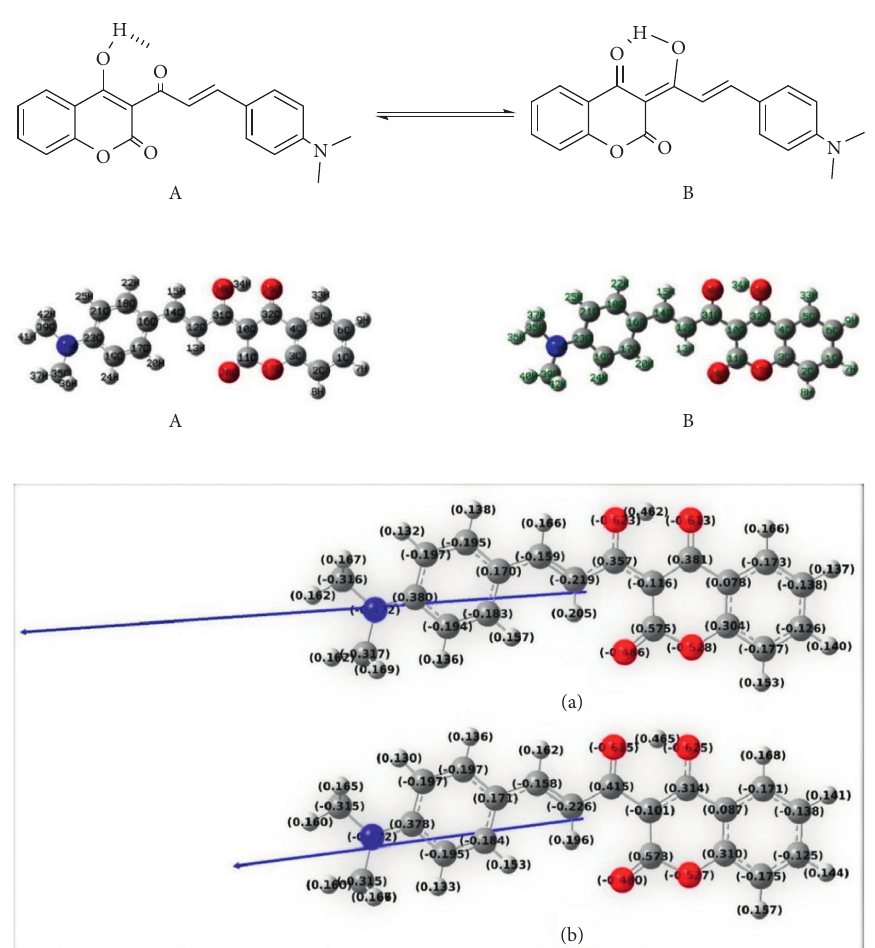
Figure 9: Optimized structures of the keto ( A ) and enol ( B ) tautomers of coumarin 3 and their charge distributions. The arrows indicate the direction of the dipole moment for each tautomer that was determined using the B3LYB/6-31G(d) level of theory. The lengths along the dipole-moment directions give the relative magnitudes of dipole moments for both tautomers. Table 4: Selected bond lengths (˚A), dihedral angles ( ° ), and bond angles ( ° ) for the gas-phase tautomers of coumarin 3, as calculated with the B3LYP/6-31G(d) level of